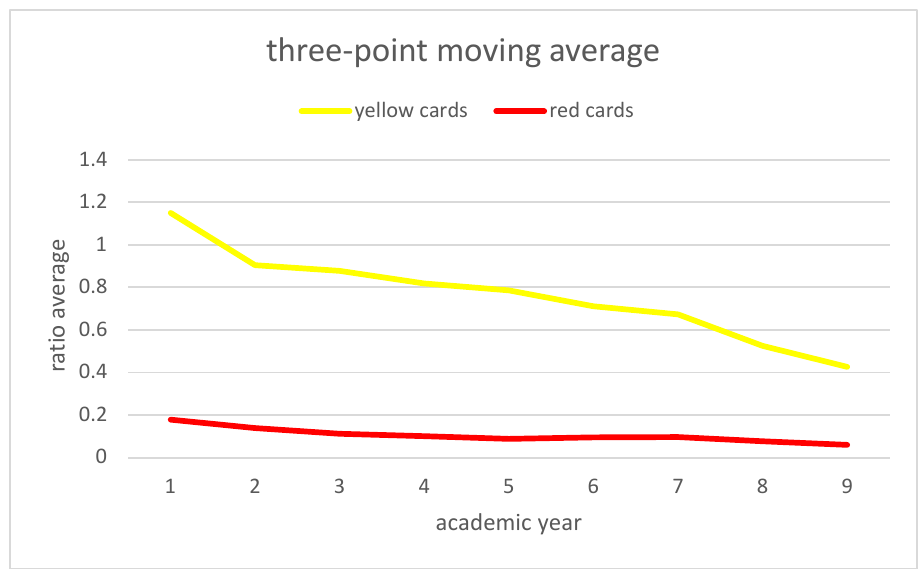
Figure 4. Three point moving average for yellow and red cards. Source: Own elaboration.